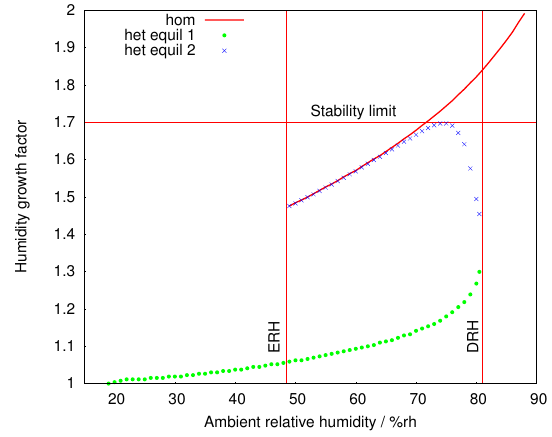
Figure 9. As in Fig. 7 but using the surface tension of pure water, σ (αβ) ∞ = 0 . 072Jm − 2